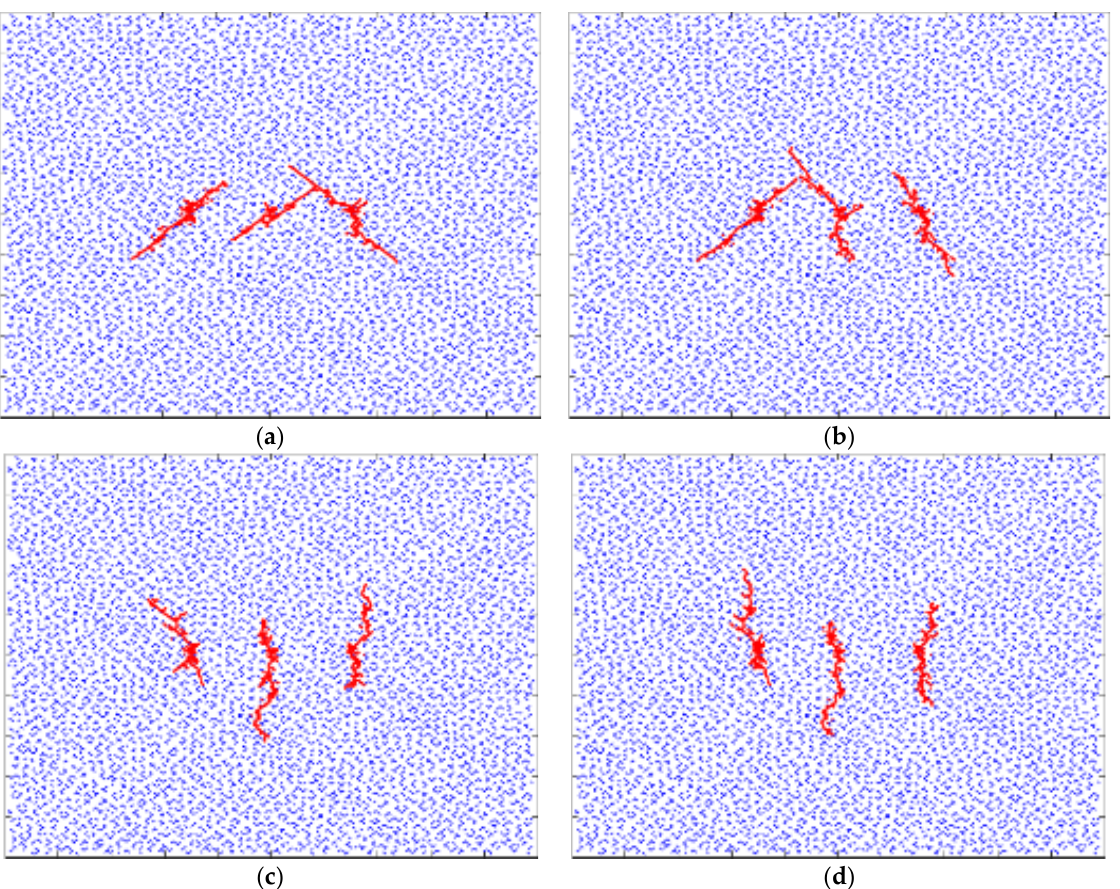
Figure 18. Fracture configuration distribution patterns during staged fracture propagation of CBM reservoirs under various values of the inhomogeneity coefficient of the in situ stress. ( a ) 1.0, ( b ) 1.08, ( c ) 1.16, ( d ) 1.24.